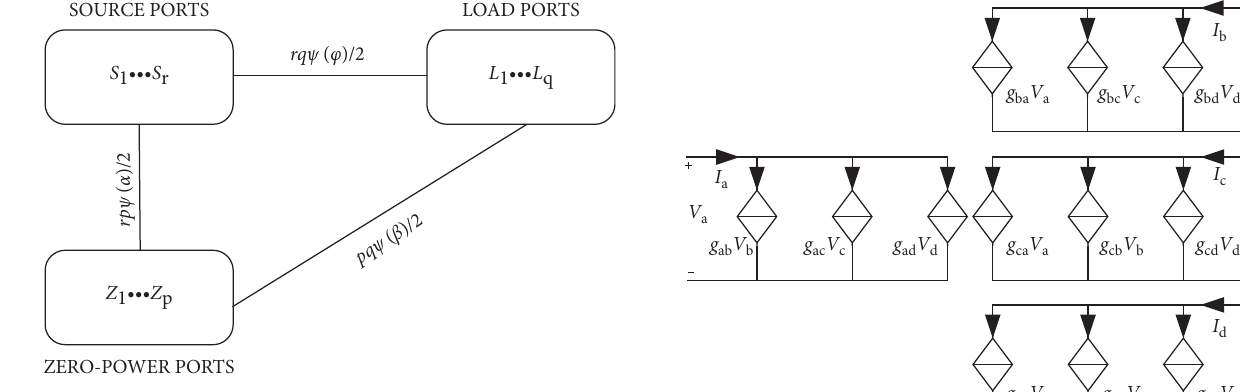
Figure 8: QP-M 2 DC maximum power transmission diagram.